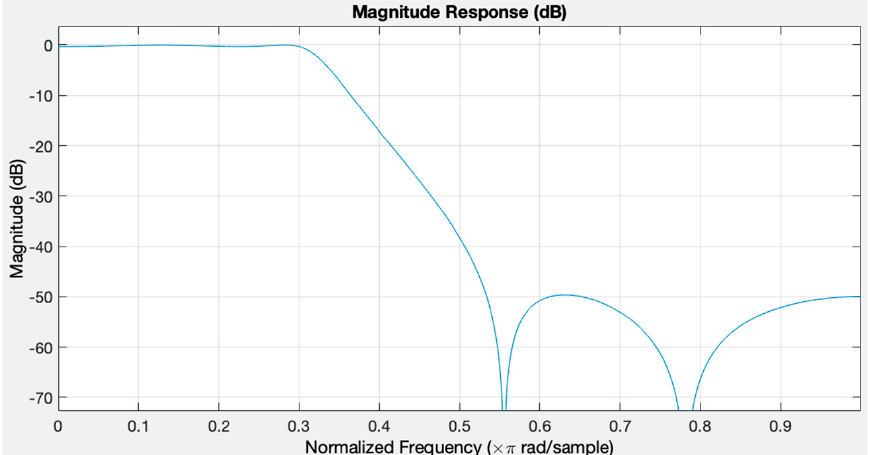
Figure 3. Magnitude response of the used filter.